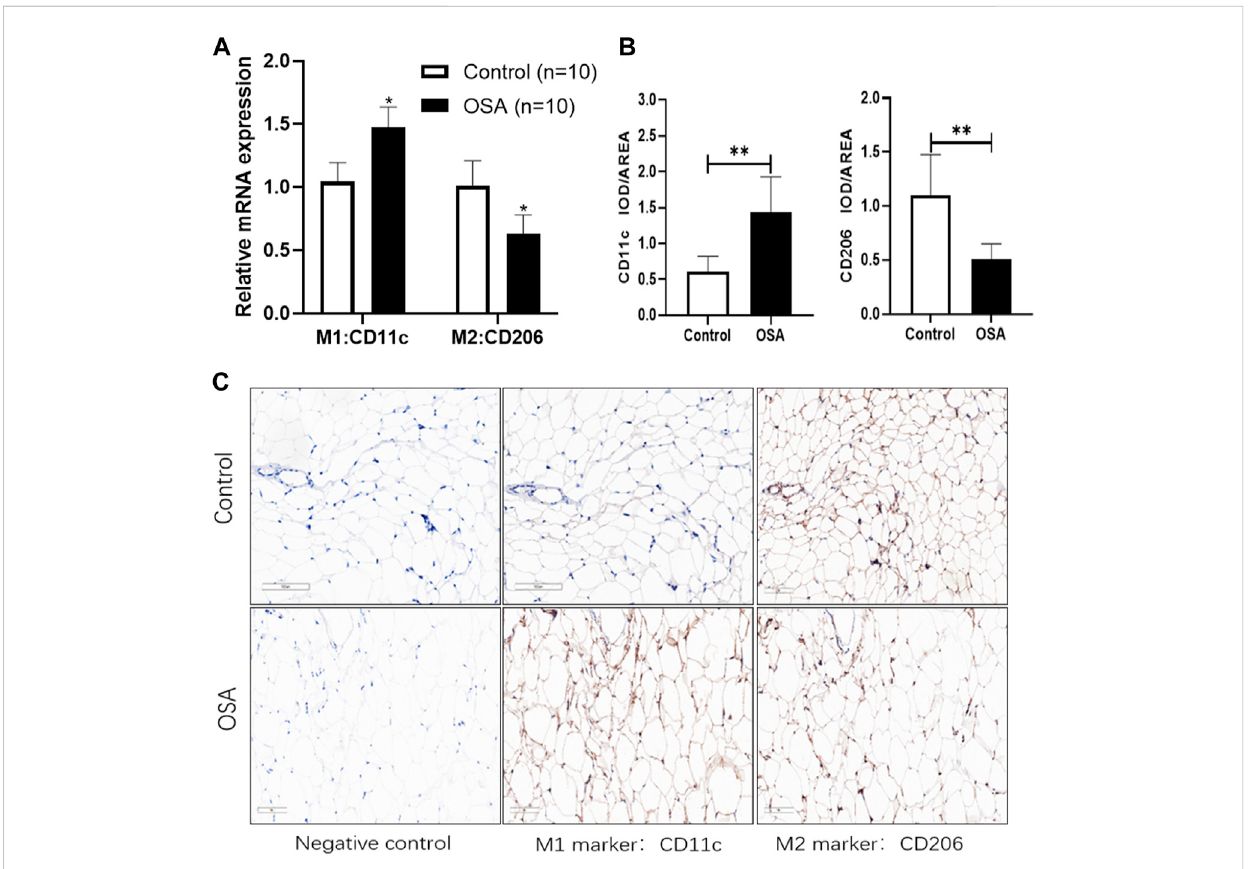
FIGURE 4 Analysis of the characteristics of macrophage in fi ltration in collected clinical samples. (A) The relative mRNA expression level of macrophage markers by RT-qPCR methods. (B) The protein expression level of macrophage markers by immunohistochemistry methods. The target protein expression was evaluated by integrated optical density (IOD)/area assay through ImageJ. (C) Representative immunohistochemistry images from the same plane. Magni fi cation, ×200, scale bar = 100 μ m. Data are presented as the mean ± SD ( n = 10), ** p <